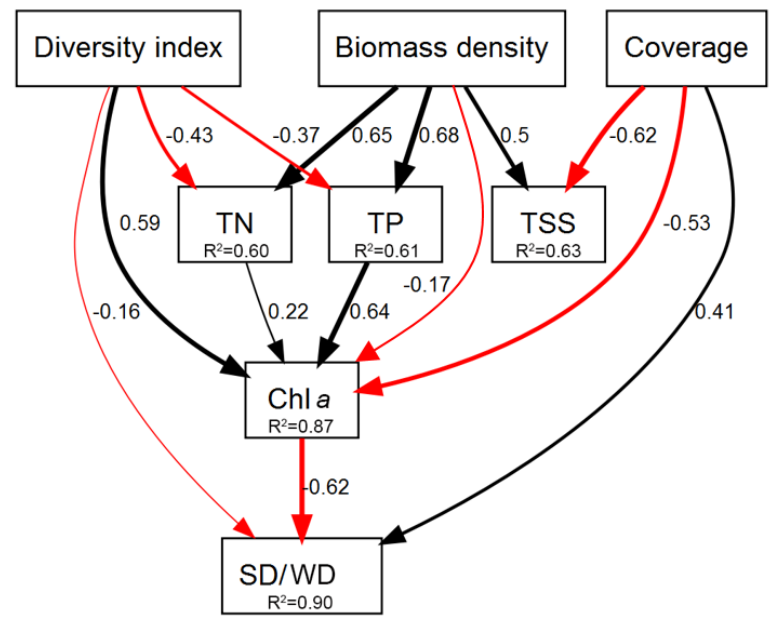
Figure 4. Path diagram between the macrophyte community metrics and the water quality parameters in restored areas (Qin-E and Wuli-E) of Lake Qinhu and Lake Wuli. Factors influencing water quality parameters mainly included SD / WD (Secchi depth / water depth ratio) and concentrations of total phosphorus (TP), total nitrogen (TN), total suspended solids (TSS) and chlorophyll a (Chl a ), averaged for three sites to correspond with mean macrophyte data. All data were log-transformed. Path thickness was proportional to the standardized regression coe ffi cient. Black and red paths represented positive and negative effects, respectively. Paths p > 0.05 were not shown, except for two paths from TN to Chl a (p = 0.07) and the diversity index to SD/WD (p = 0.08).